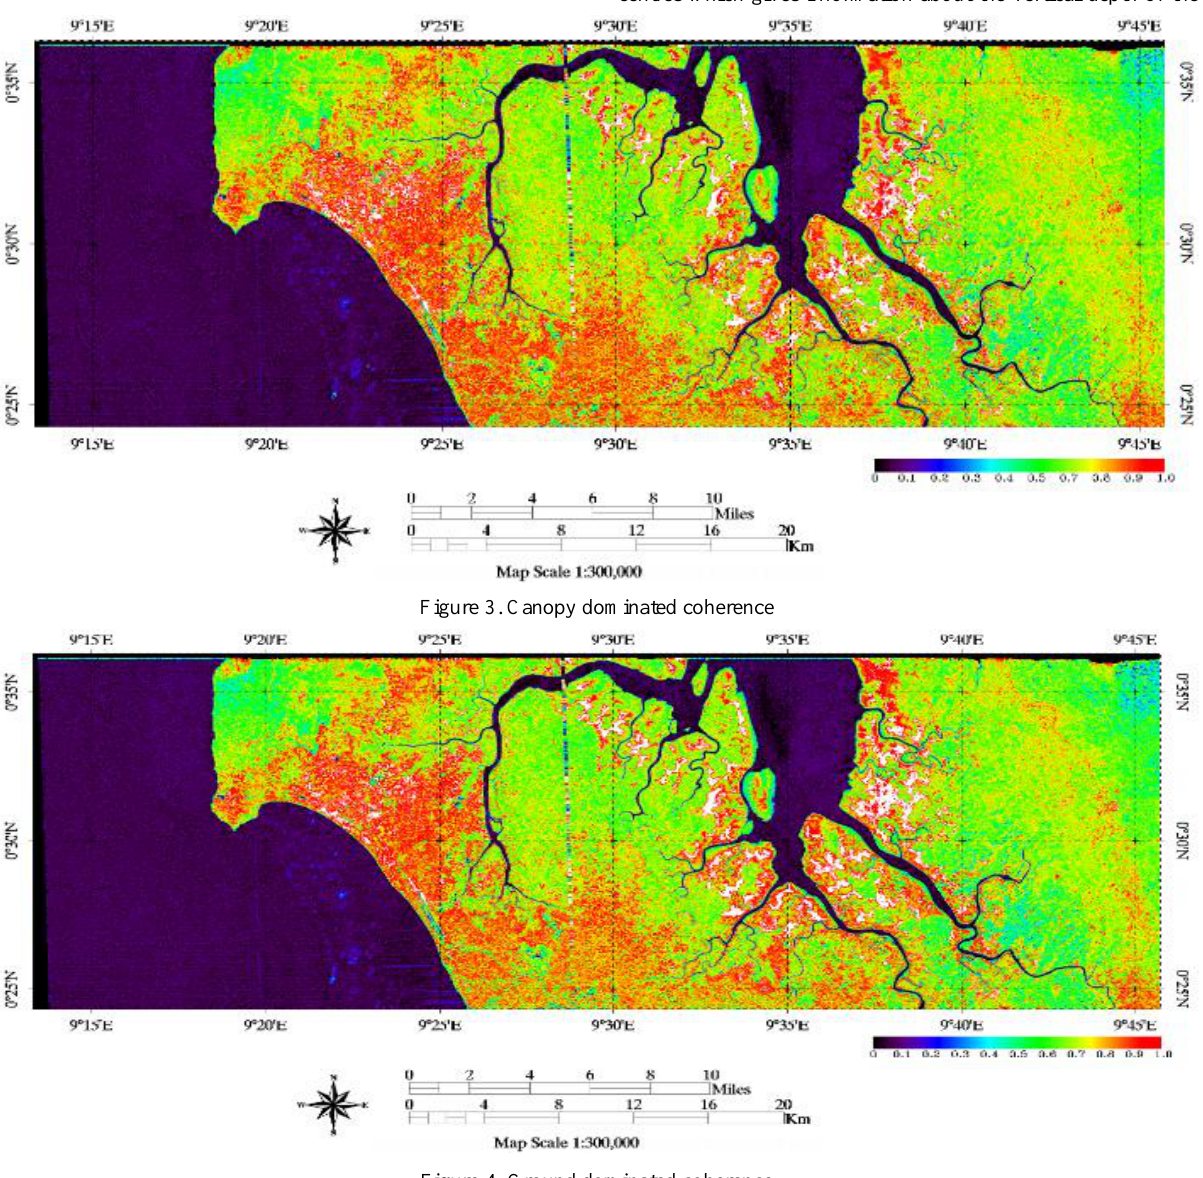
Figure 4. Ground dominated